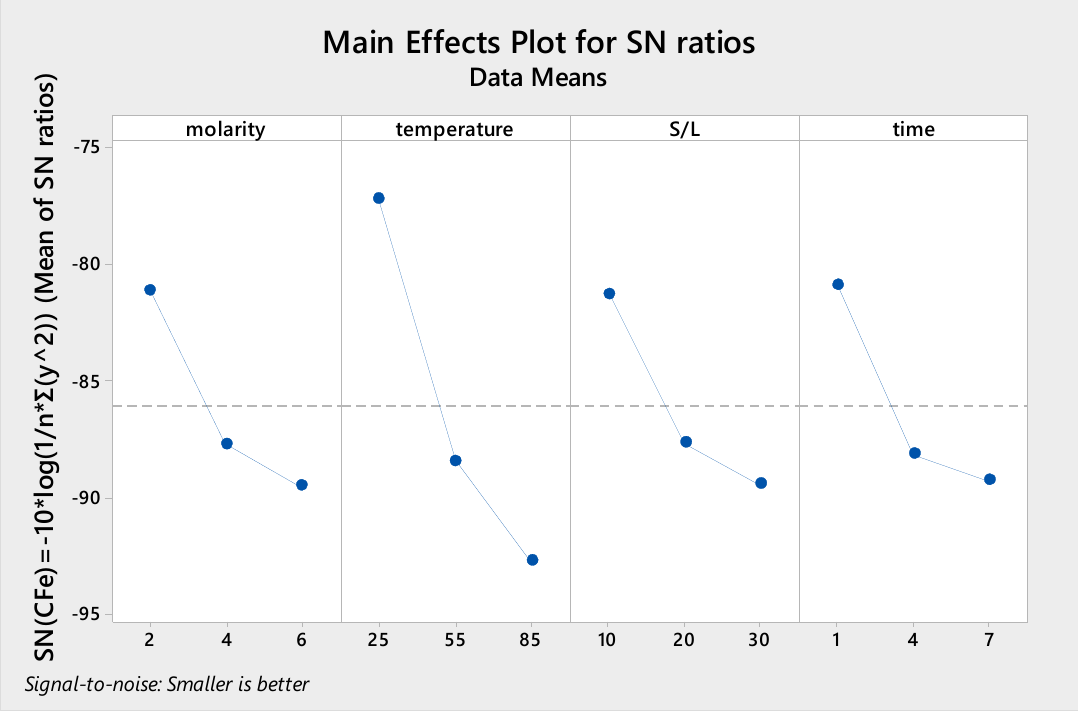
Figure 4. Effects of each parameter (( A ) Acid molarity, ( B ) Temperature, ( C ) Solid-to-Liquid ratio (S/L), and ( D ) Leaching time) associated with their levels on the statistical performance of S/N ratio for Fe.